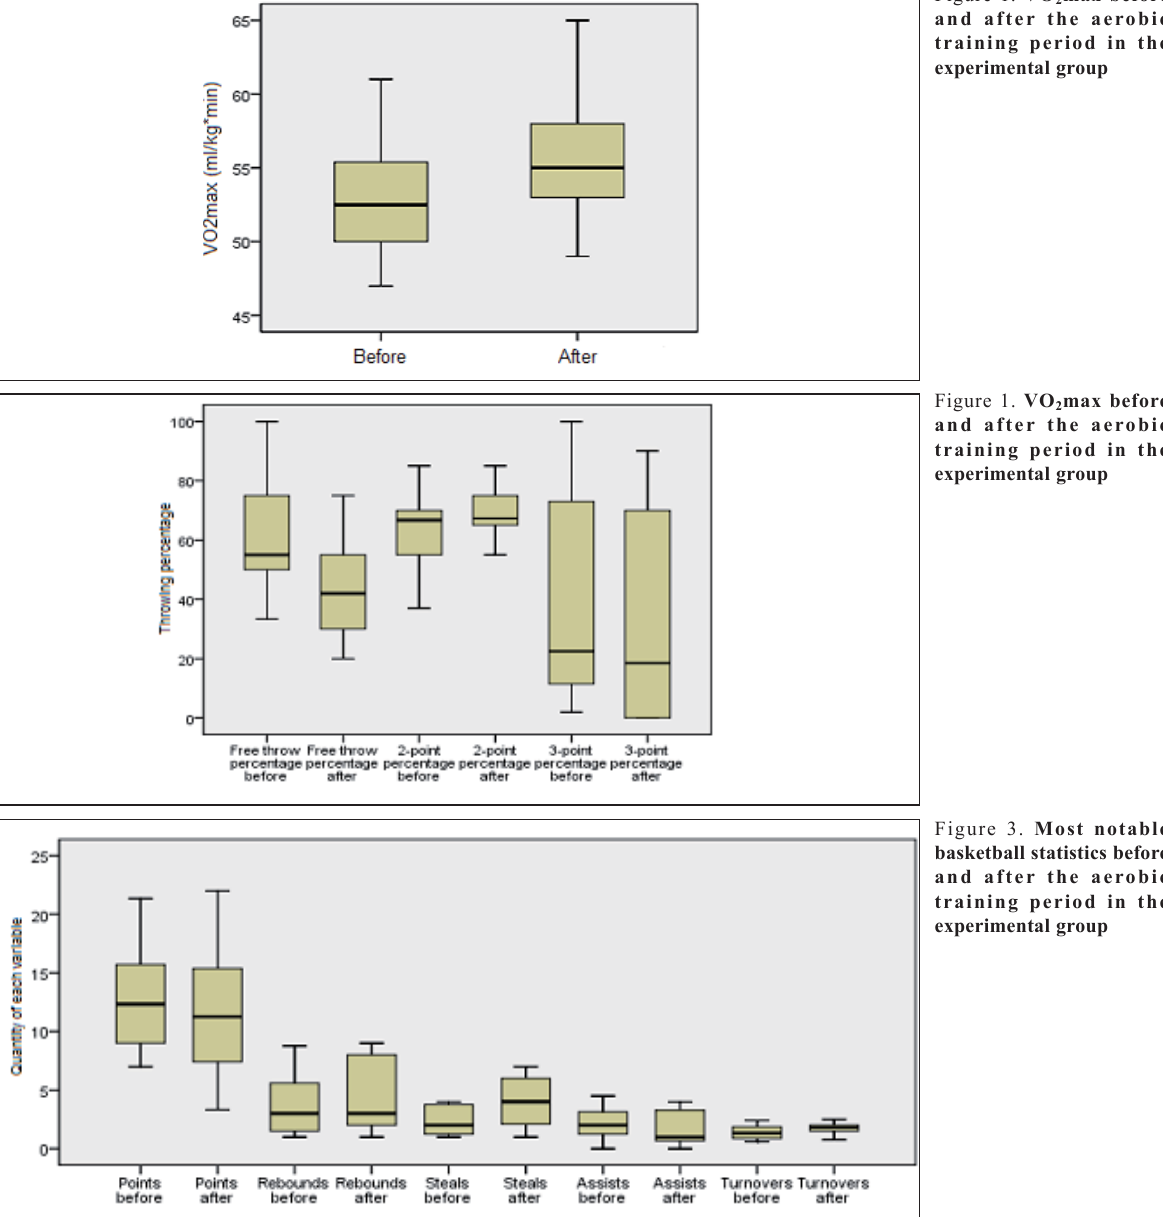
Figure 1. VO 2 max before and after the aerobic training period in the experimental group